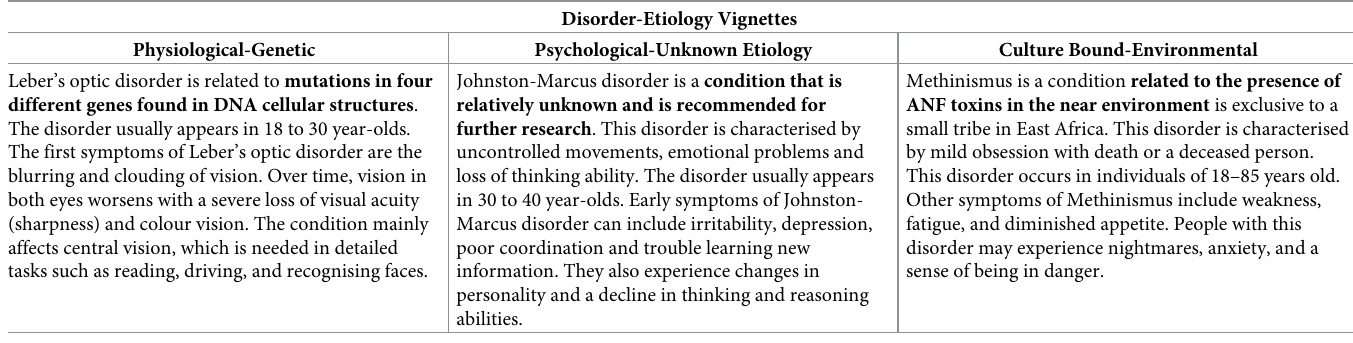
Table 1. Example of Disorder-Etiology paired vignettes.